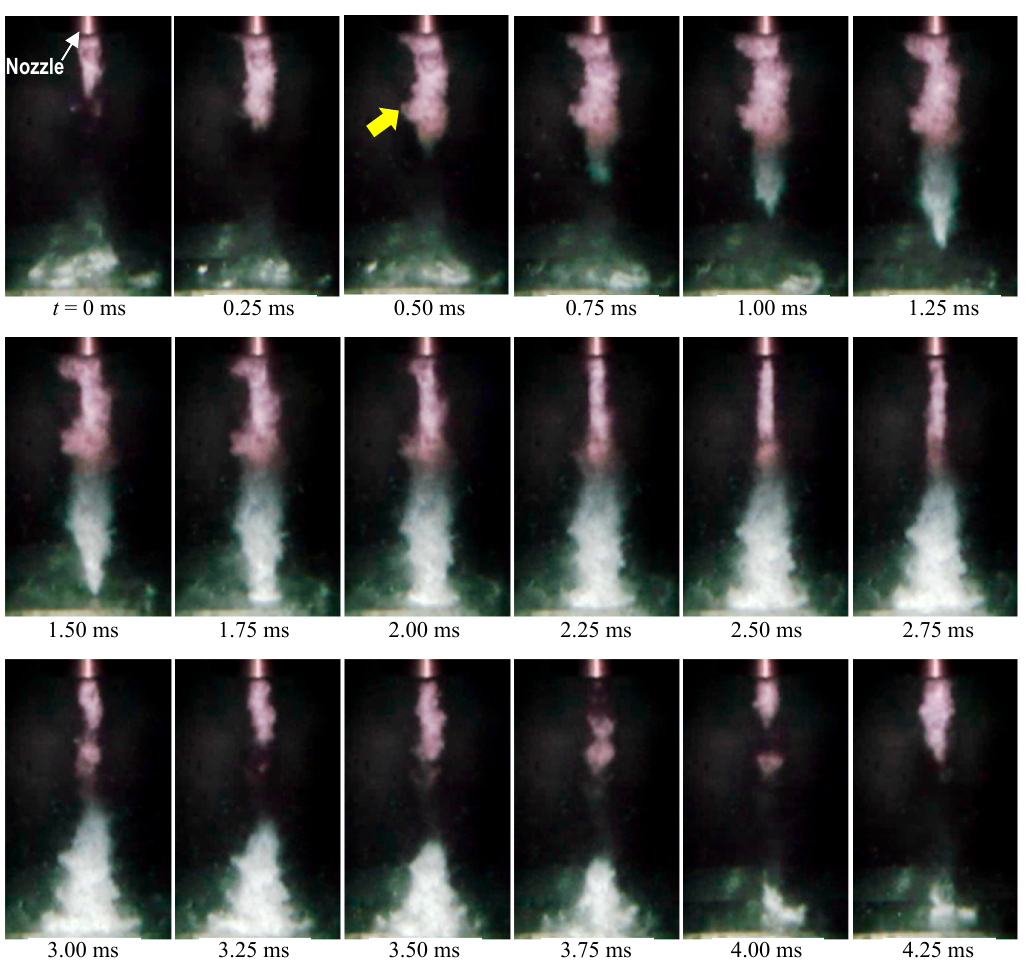
Figure 6. Aspects of impinging cavitating jet observed by high-speed video camera (cylindrical nozzle, nozzle diameter d = 2 mm, upstream pressure p 1 = 30 MPa, downstream pressure p 2 = 0.1 MPa, standoff distance s = 222 mm).